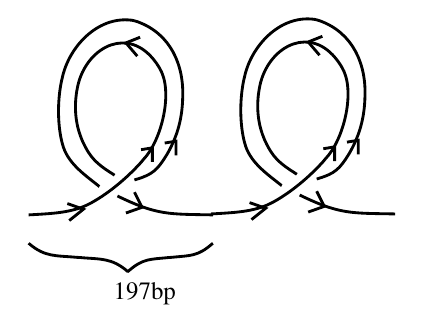
Fig. 11. The nucleosome has the length about 197bpand its writhe − 2